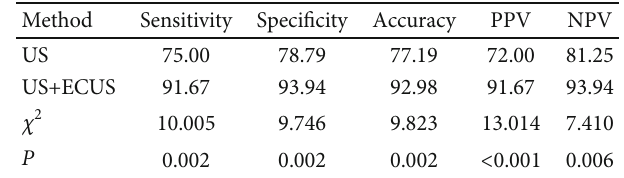
Table 5: Comparison between the results of US and biopsy.